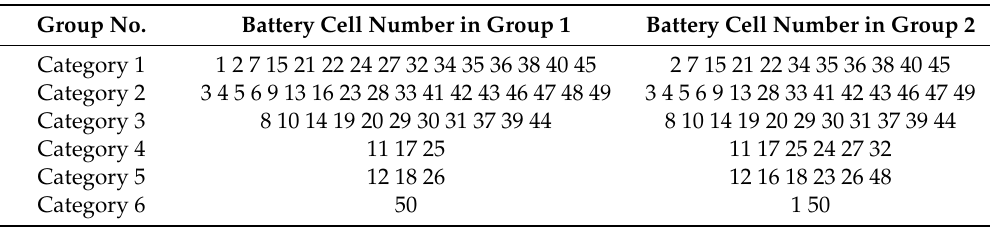
Table 5. Categories of 50 battery cells.